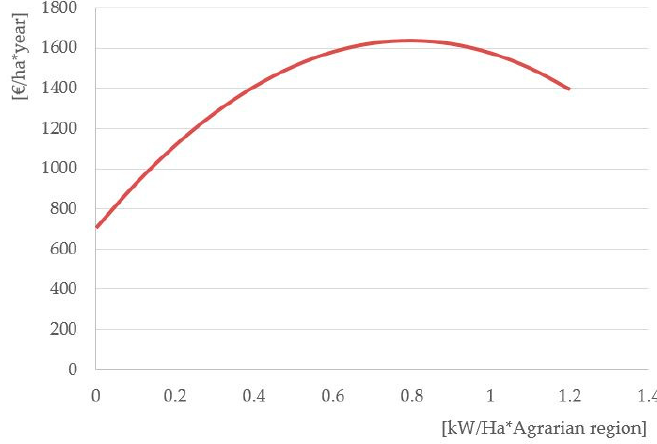
Figure 2. Function of installed kilowatt per hectare in the agrarian region on rental price ( kw_r ).